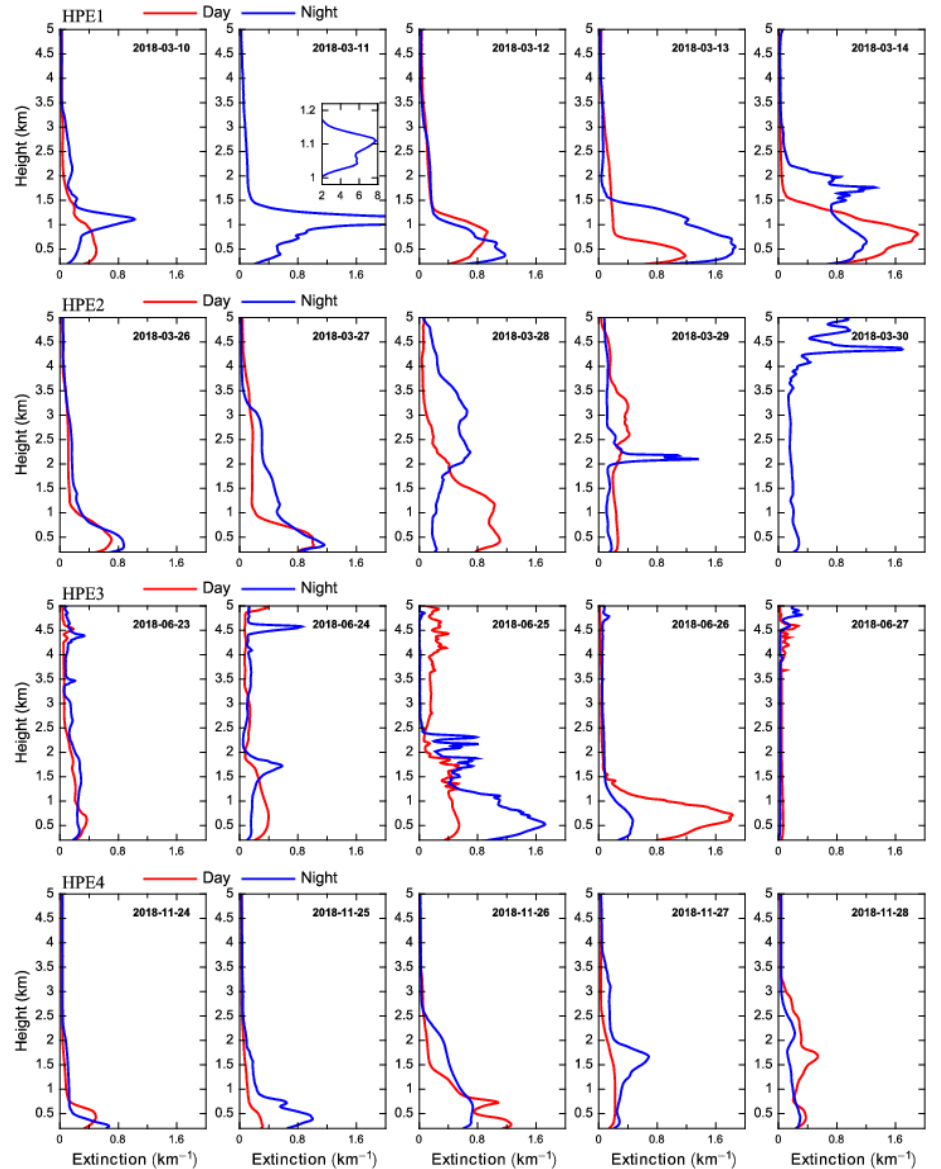
Figure 7. Time series of aerosol EC profiles retrieved by Lidar during four heavy pollution episodes (HPE1, 2, 3, and 4) in Beijing in 2018.